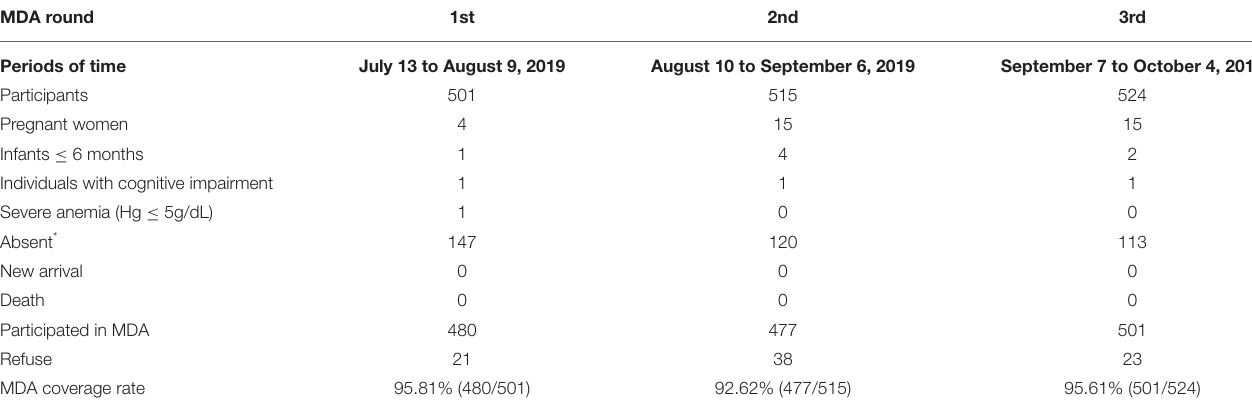
TABLE 1 | Artemisinin-Piperaquine-Mass Drug Administration coverage rates in zone A. MDA